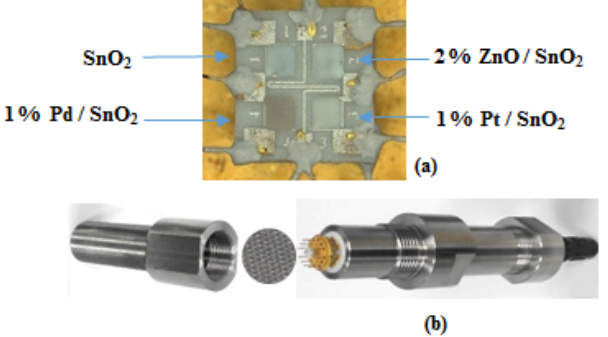
Figure 2. The MO sensor array (a) and housing (b) . A special flange was designed for the adaptation of the sensor to the exhaust gas tube and the separation of the sensor element with a filter for protection against PM and soot